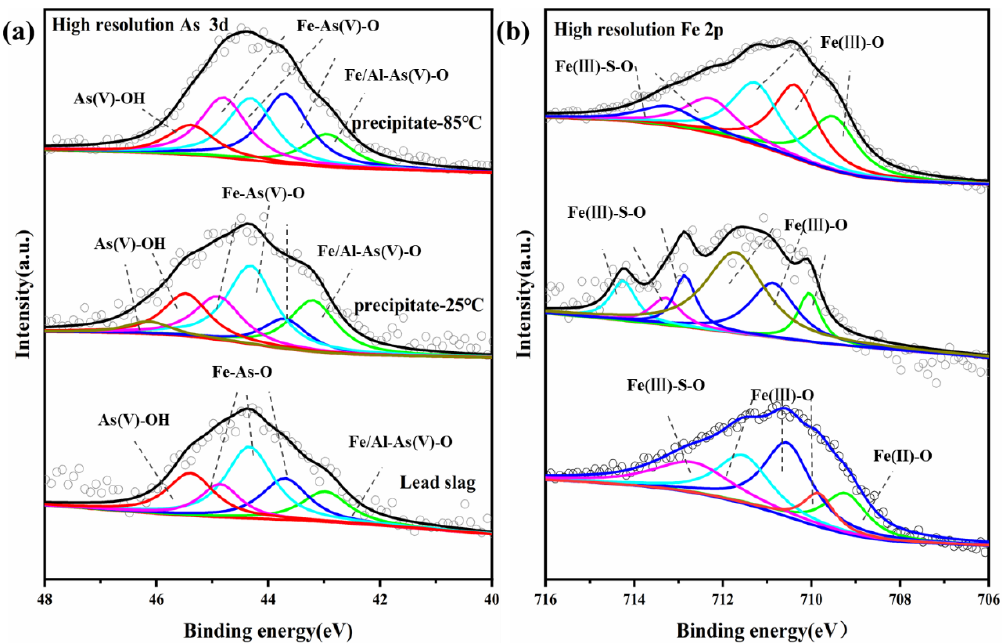
Figure 9. XPS spectra of (i) lead slag, As-bearing precipitates obtained after reaction at 25 °C (ii) and